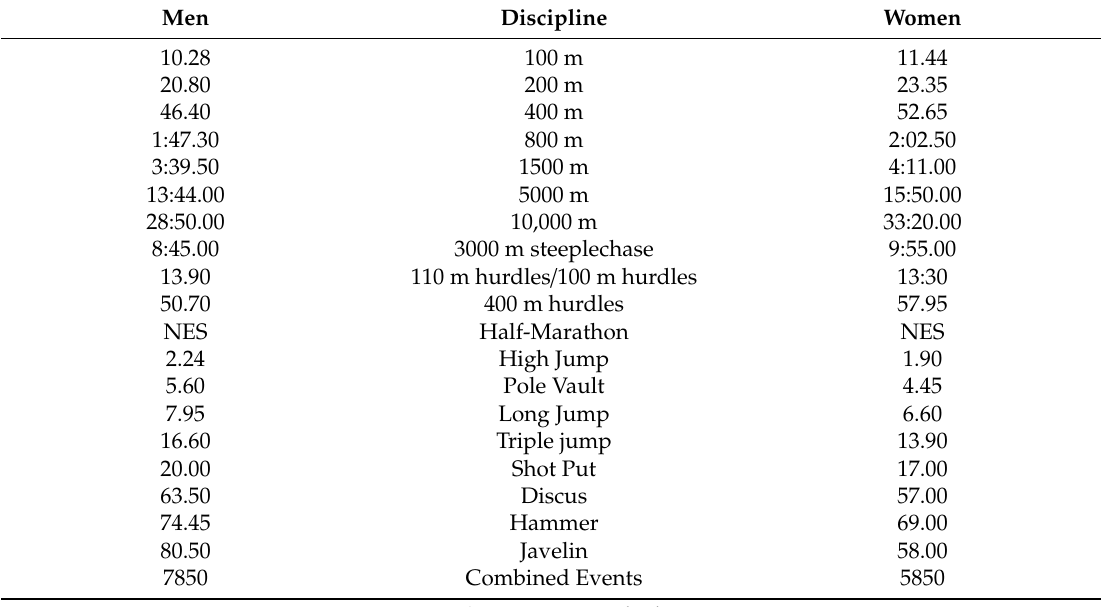
track and field gold medal winners in European Championships, World Championships and Olympic Games from 1980 to 2019 are represented in the top 20 all-time best lists for girls and boys at ages 15 and 18 years. Table 1. European Athletics Championships 2020—Entry Standards (https: // www.european-athletics.org). Men Discipline Women